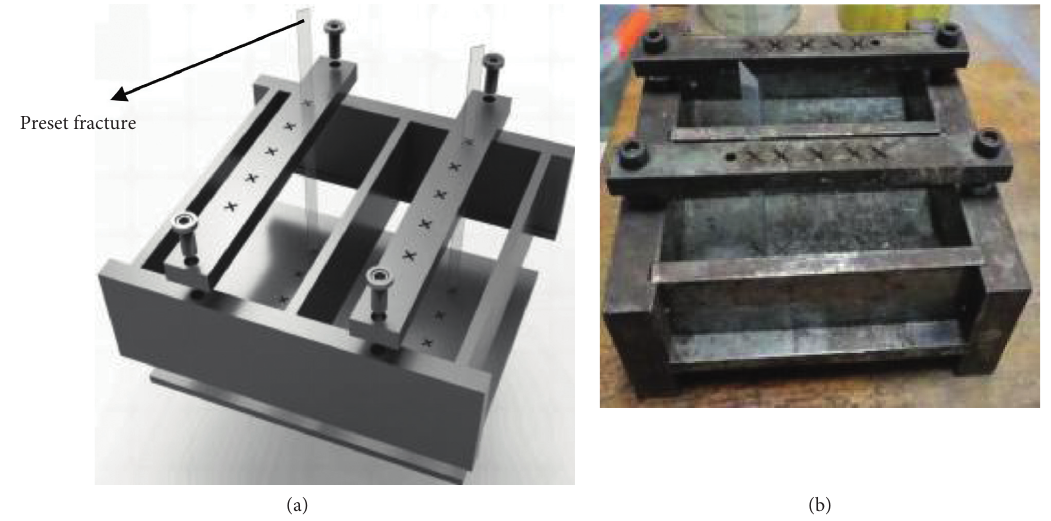
Figure 2: Production mold for rock-like specimen with (a) three-dimensional sketchy map and (b) finished mold.